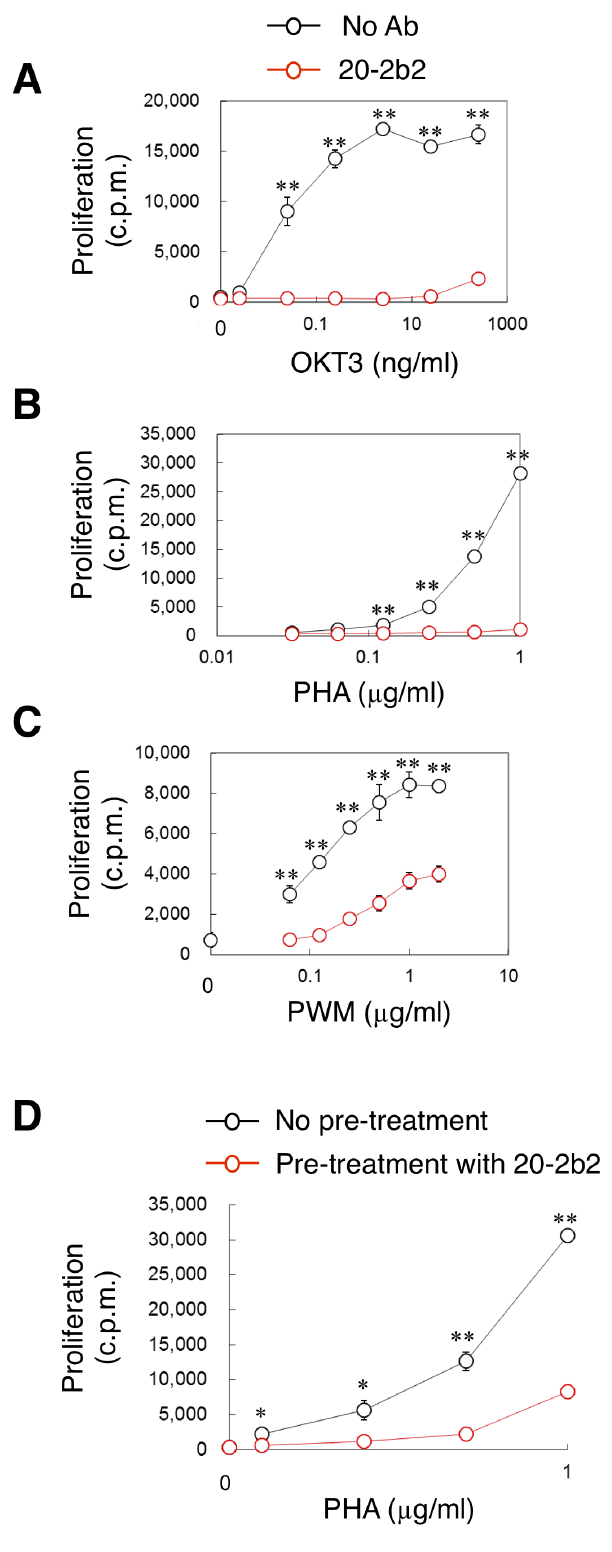
Figure 2. 20-2b2 inhibited the activation of T cells invitro . (A–C) The PBMCs of healthy donors were cultured with an anti-CD3 Ab (OKT3) (A), PHA (B), or PWM (C) in the presence (red symbols) or absence (black) of 20-2b2 (50% SN). (D) PBMCs were pre-treated with medium (black) or 20-2b2 (red) at 37 u C. Cells were washed three times and cultured with PHA two hours later. Cell proliferation was measured two